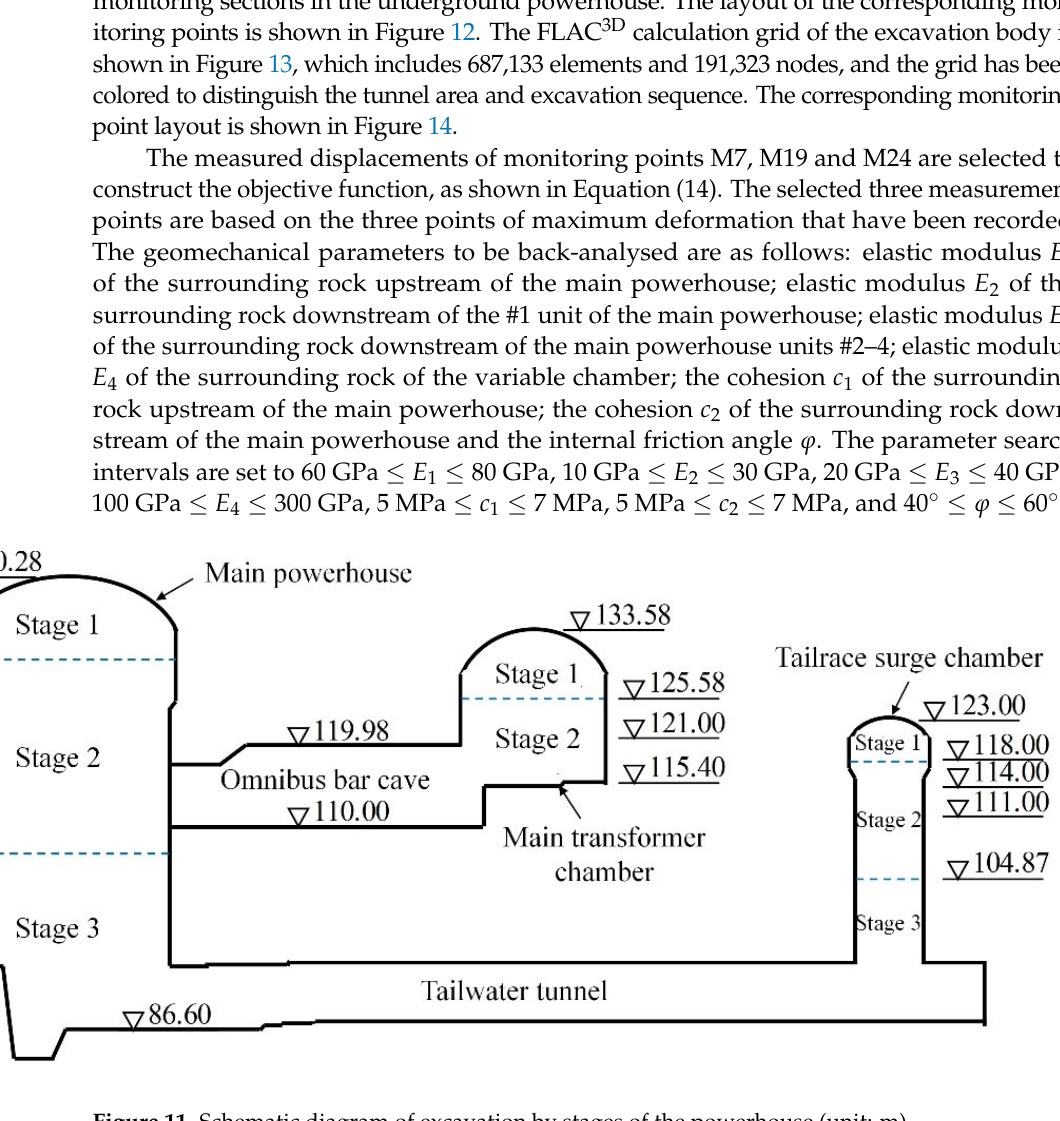
Table 4. The results calculated by the two methods.